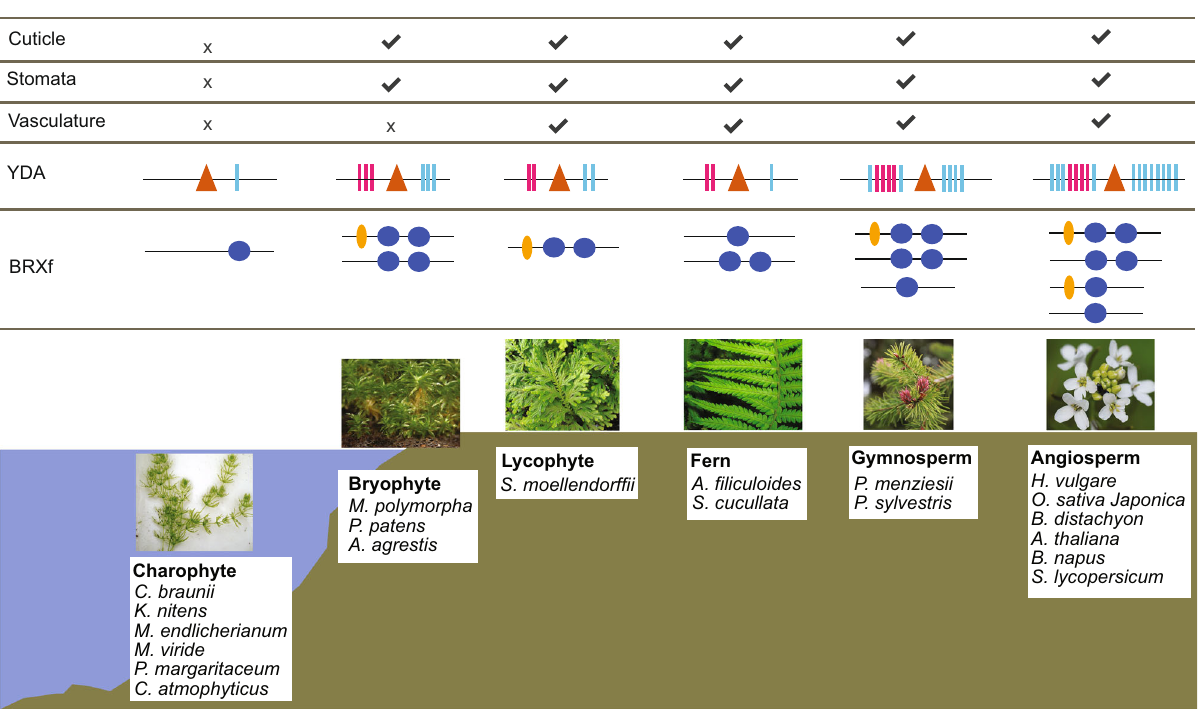
Fig.5|Geographicstructuringof HvYDA1 haplotypes.a SNPsiteswithin HvYDA1 identi fi ed from the whole-exome sequencing data of 440 diverse Hordeum spon- taneum (wild barley), H. vulgare cultivar and landrace accessions. Bars indicate exons while orange bars represent the kinase domain. Black triangles indicate noncoding regionSNP sitesand synonymous SNP sites while red triangles indicate nonsynonymous SNP sites. Haplotypes (HPs) carrying variants causing a loss or gainofpotentialphosphorylationsitesaswellastheextranonsynonymousSNPsite carried by HP_25, are noted below. Red letters indicate putative phosphorylation